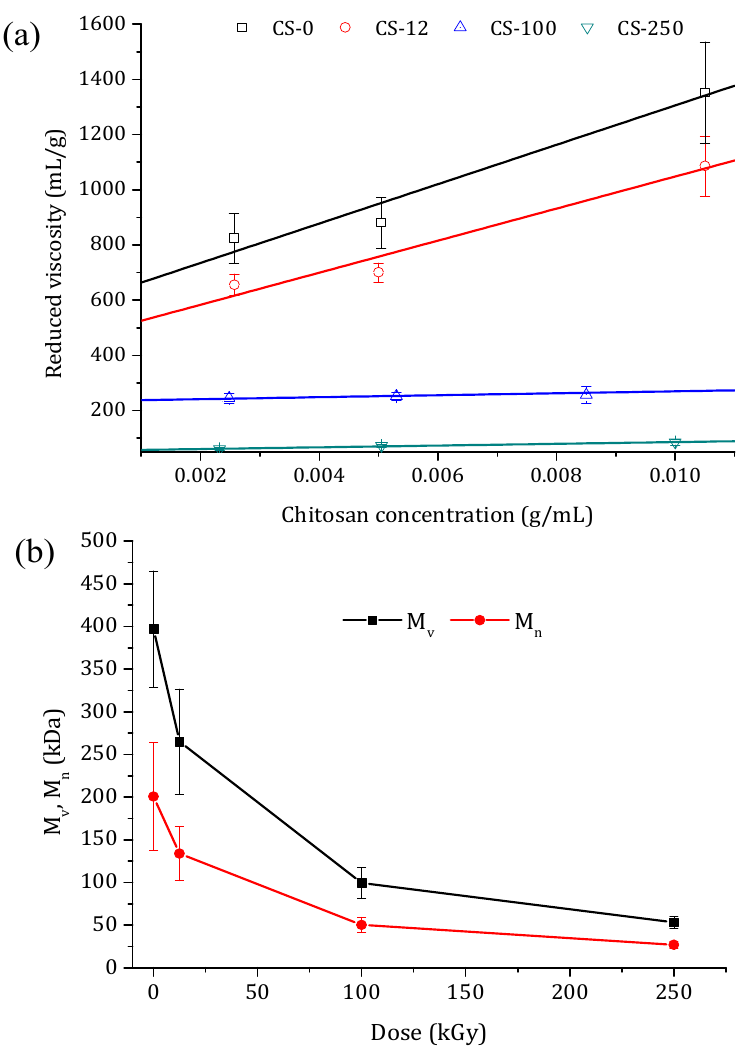
Figure 5. ( a ) Reduced viscosity as a function of the chitosan concentration for non-irradiated (CS-0) and irradiated chitosan powders at different doses: 12.5 kGy (CS-12), 100 kGy (CS-100), and 250 kGy (CS-250). ( b ) Change in the viscosity average molecular weight, M v , and the number average molecular weight, M n , of the chitosan powders with the applied irradiation dose.